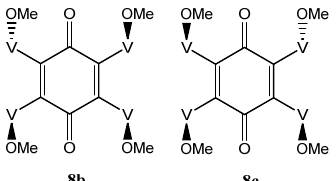
Figure 6. Tetra-adducts with three vindolines with same orientation.